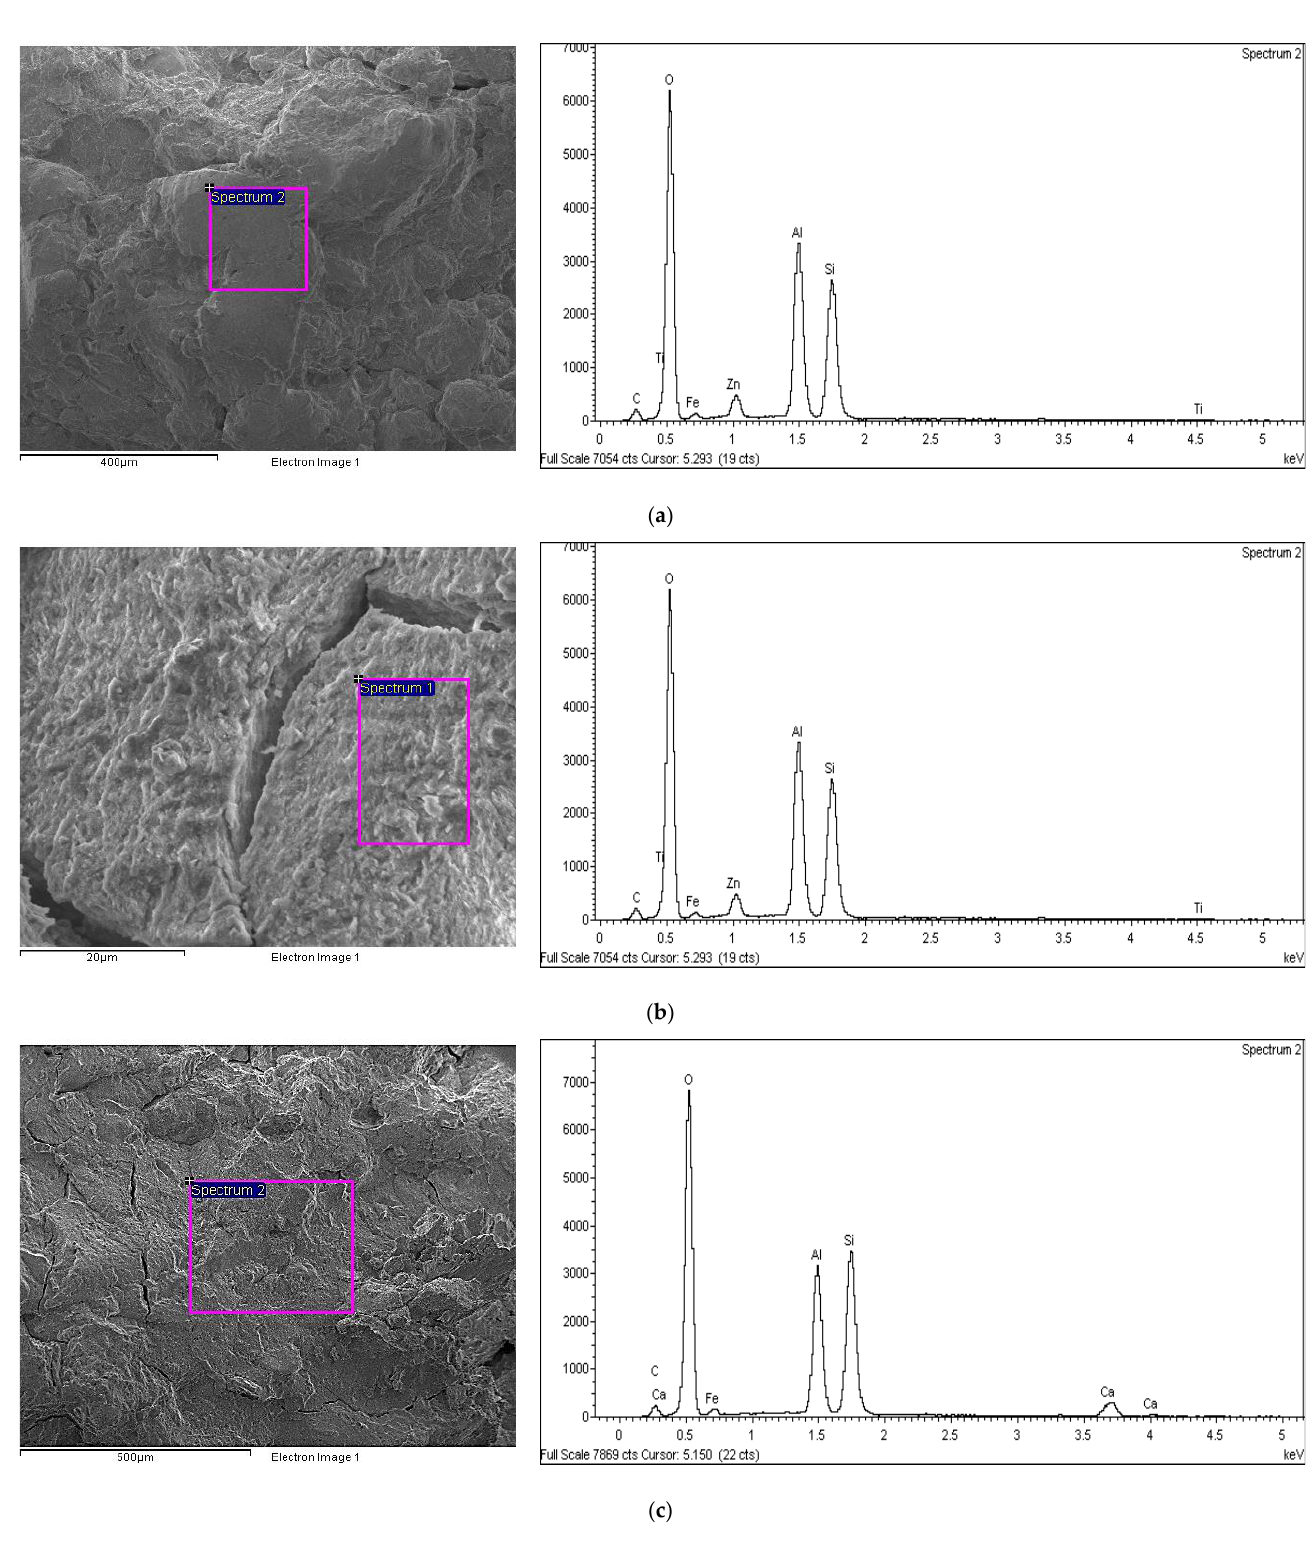
Figure 11. Twenty-eight-day curing period of the EDX spectrum for: ( a ) NLS, ( b ) LS + 5% OPC, and ( c ) LS + OPC + 5% HC. Table 4. EDX analysis for untreated and treated lateritic soil after the compressive strength test at a curing period of 28 days.